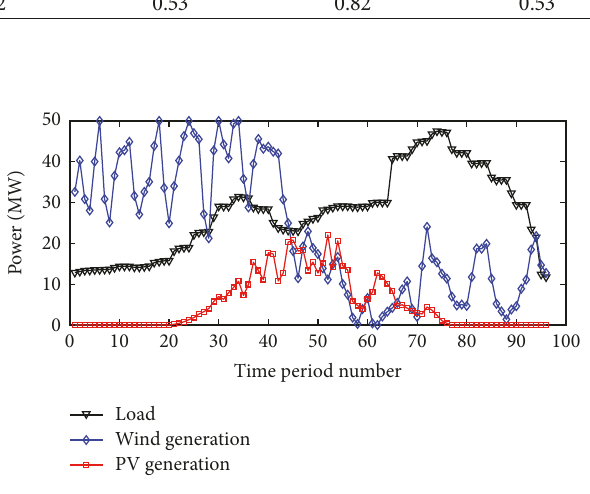
Figure 4: New energy power generation output and load distribu- tion.